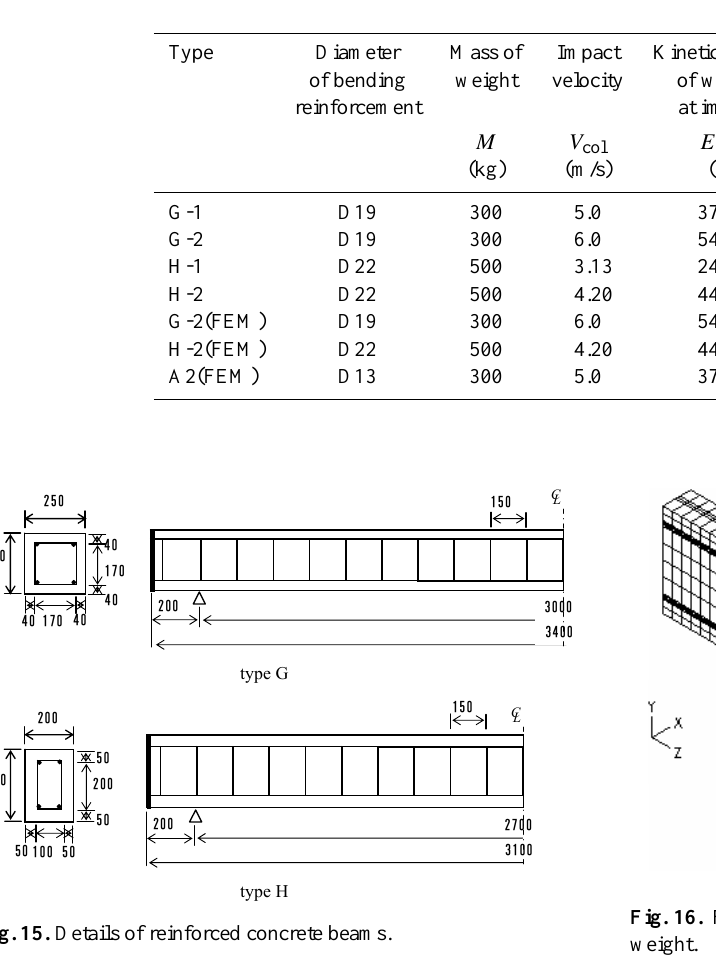
Table 4. Impact conditions and maximum displacements.